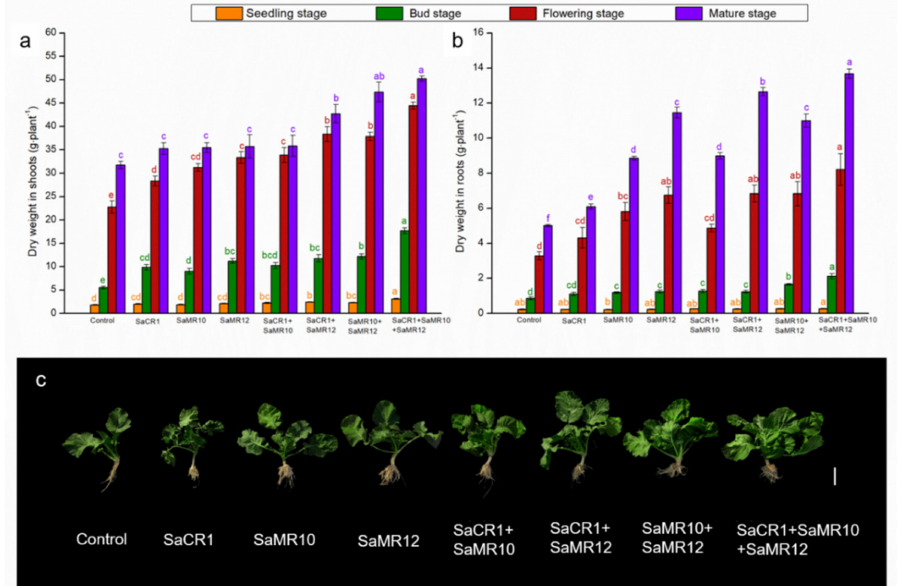
Figure 2. Effects of PGPB inoculants on dry weight (DW) in ( a ) shoots and ( b ) roots of B. juncea at different growth stages. Orange, green, red, and purple represent the seedling stage, bud stage, flow- ering stage, and mature stage, respectively. The letters of corresponding colors indicate the significant differences among different treatments at the same growth stage. ( c ) Plant growth condition at the bud stage. Bar = 10 cm.